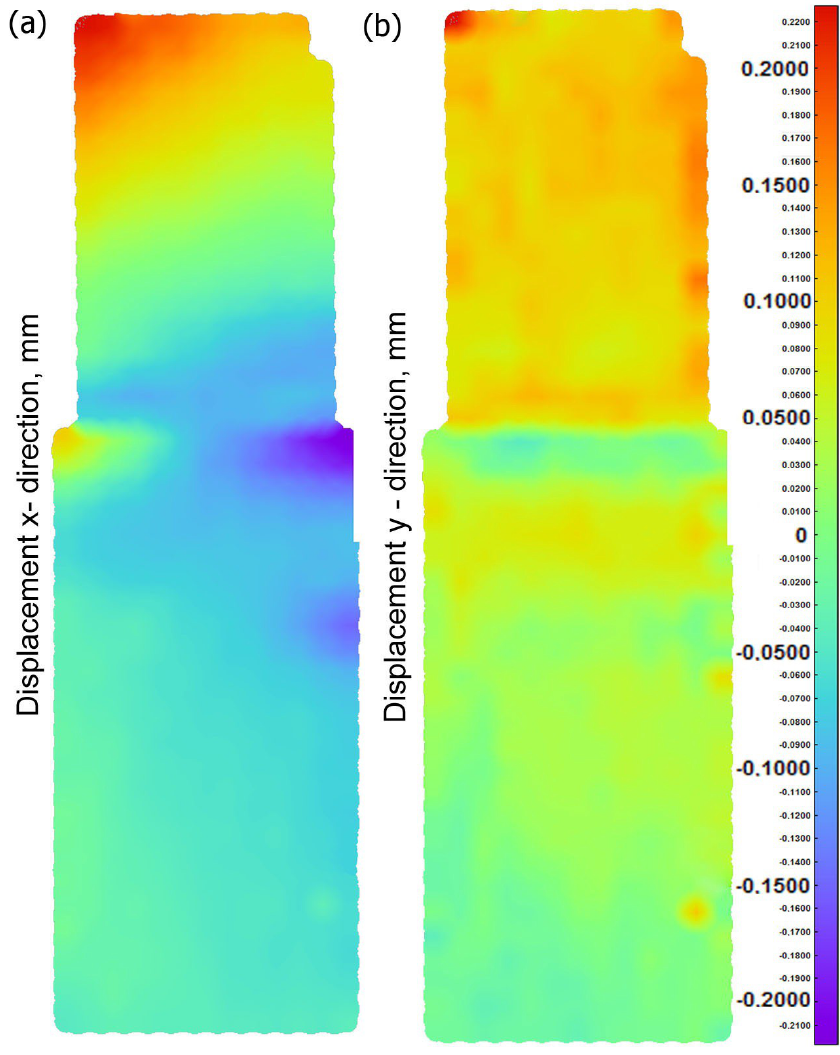
Figure 9. Displacement ( a ) in the x axis, ( b ) in the y